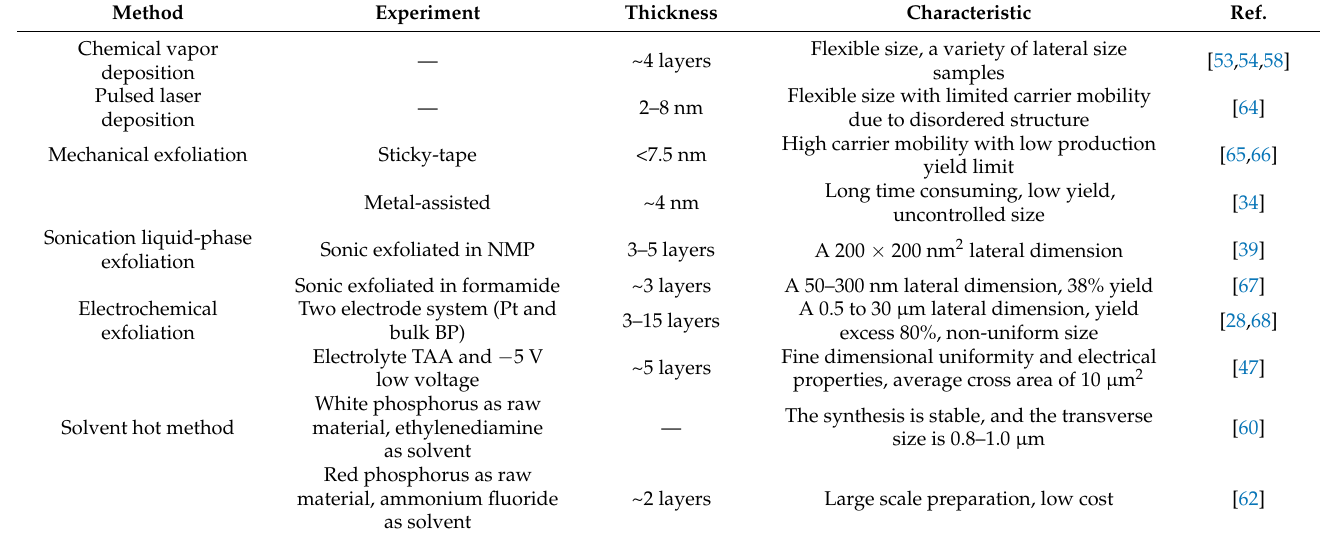
Table 1. Comparison of some classical preparation methods and characteristics of 2D